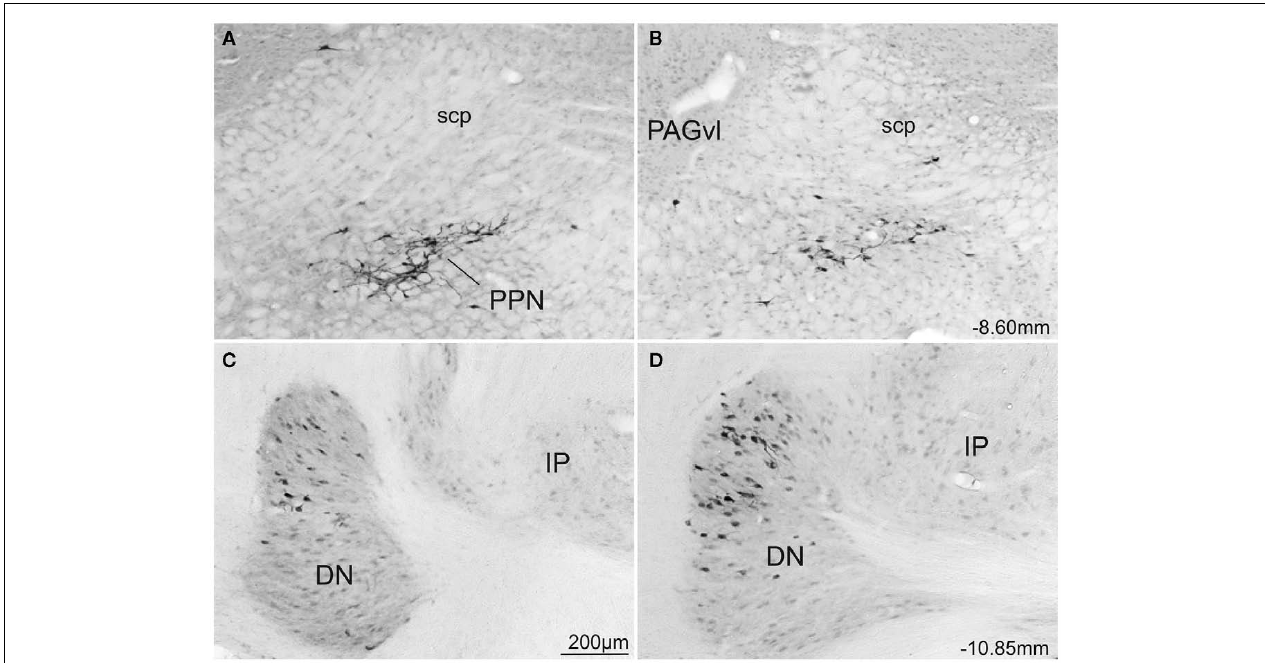
FIGURE 8 | Photomicrographs of transverse sections of the rat brain showing some of the areas with similar topography of FG-stained cells from a rat injected into the SCm (A,C) or into the SCl (B,D). Abbreviations: see list.